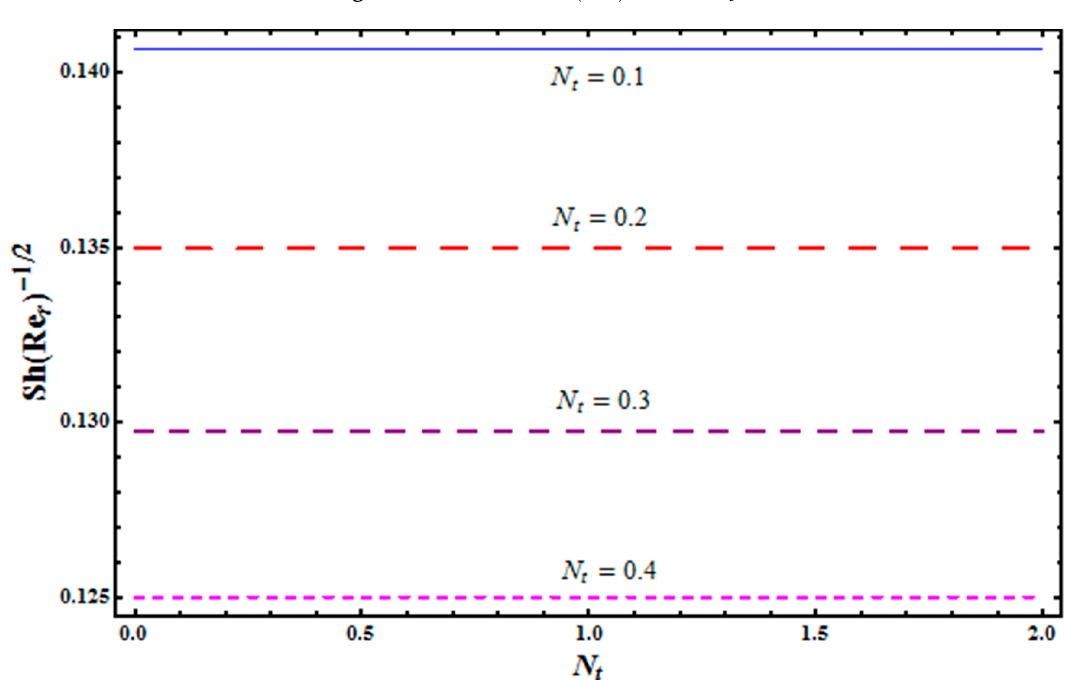
Figure 18. Curves of Sh ( Re r ) − 1/2 for N t